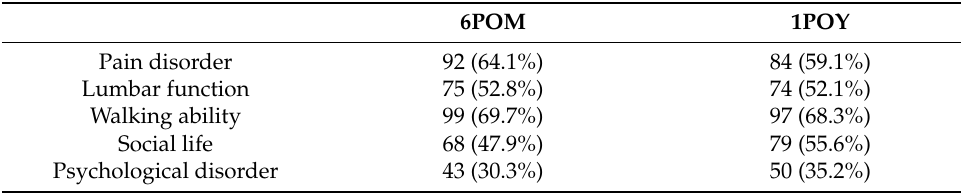
Figure 1. Box-and-whisker plot for comparison of valuables of patient-reported outcome at baseline and follow-up after surgery ( n = 142). Both 6-month and 1-year postoperative scores of Roland- Morris Disability Questionnaire ( A ) and symptom severity ( B , left panel) and physical function ( B , right panel) of Zurich Claudication Questionnaire significantly improved compared to the preoperative scores. Table 2. The number of effective cases of surgical treatment on JOA Back Pain Evaluation Question- naire (JOABPEQ) ( n = 142).